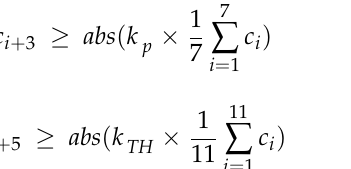
Table 2. Statistical analysis results of PM 2.5 concentration data. Site